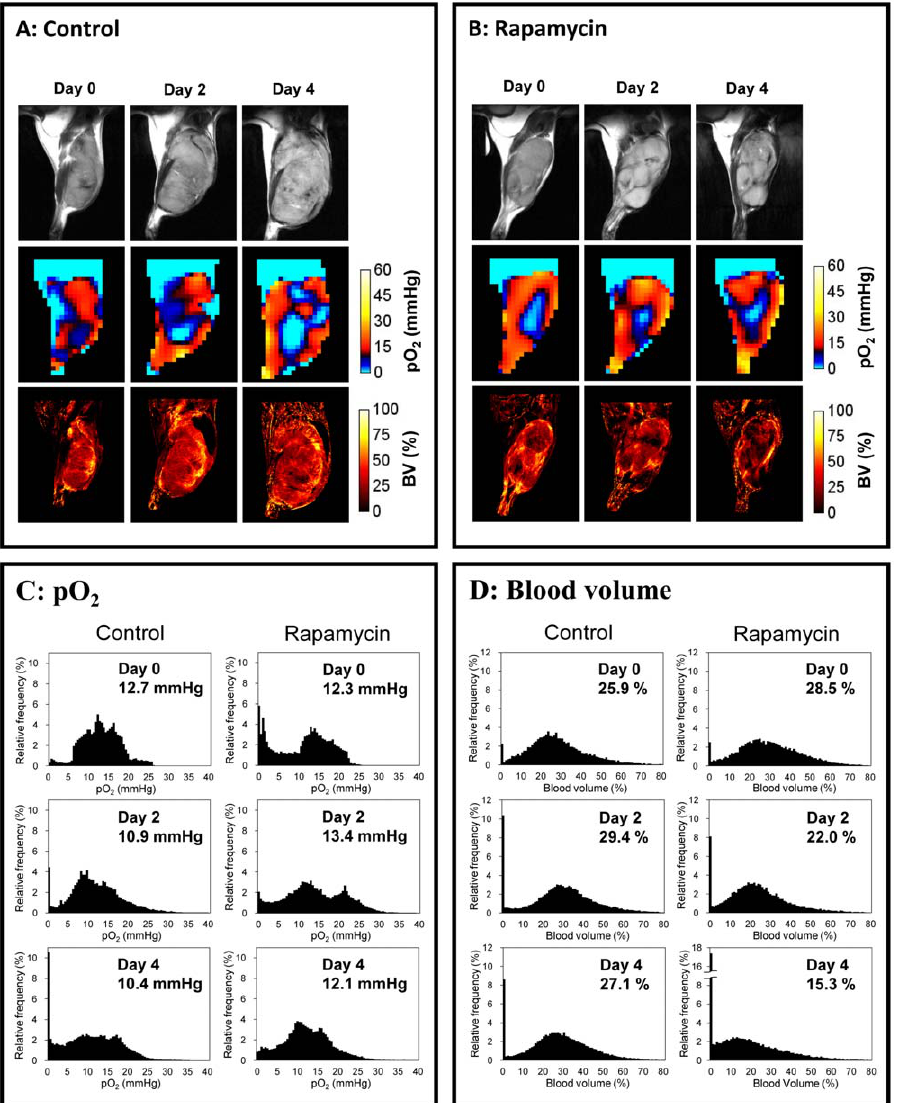
Figure 3. Effect of rapamycin treatments on tumor pO 2 and blood volume. Anatomy, pO 2 , and blood volume images of SCC tumor in mice leg treated with vehicle (A) and 10 mg/kg bw/day rapamycin (B). The center slice of each 3D image is displayed. Treatment was initiated 8 days after tumor implantation (Day 0). The images of day 0 were obtained before beginning of the treatments. (C, D) Frequency histograms of pO 2 and blood volume in the SCC tumors of (A) and (B). The values indicate median pO 2 and blood volume in the tumor region.